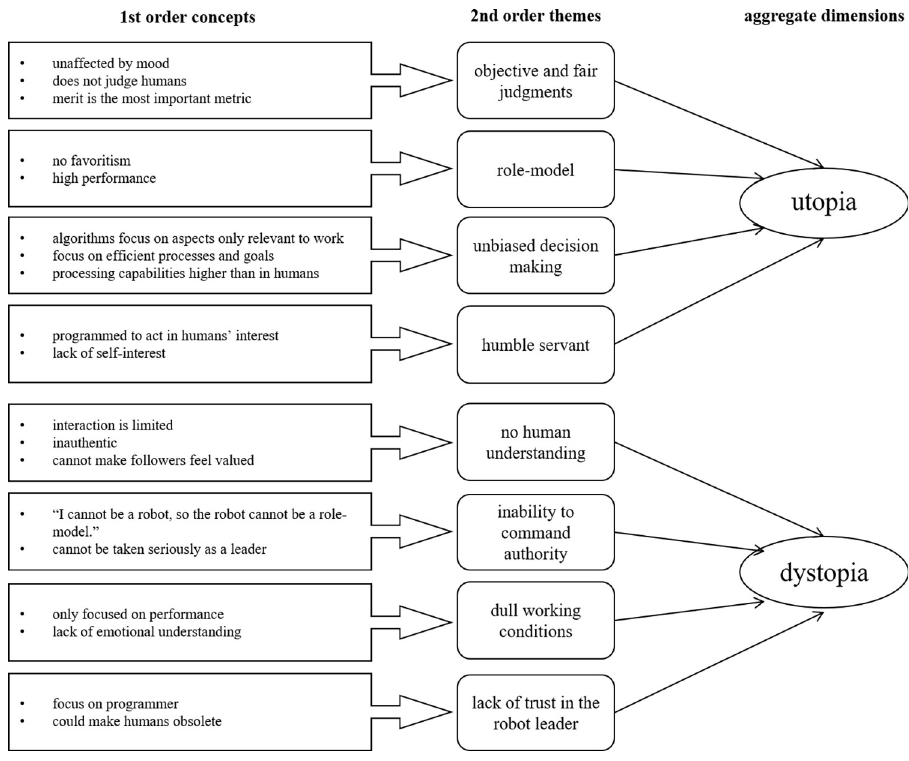
Fig 2. Gioia methodology based on the interviews and group discussions.